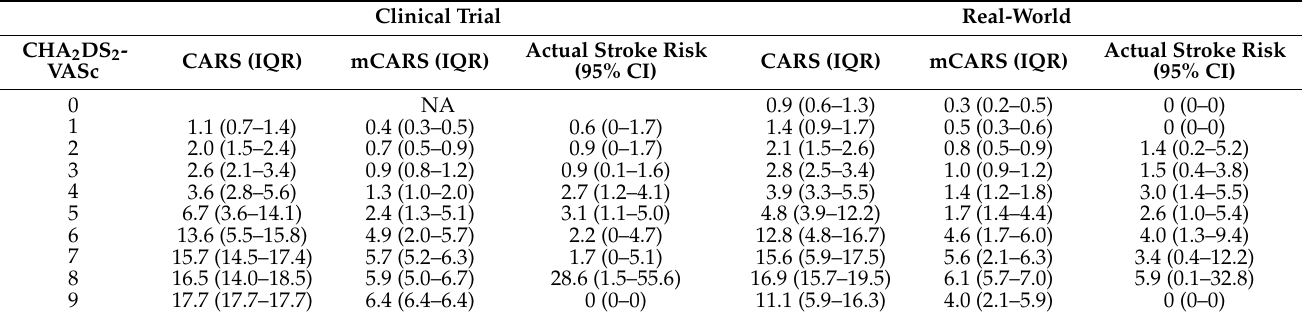
Table 1. CARS, mCARS, and actual stroke risk stratified by CHA 2 DS 2 -VASc score in clinical trials vs. the real-world.